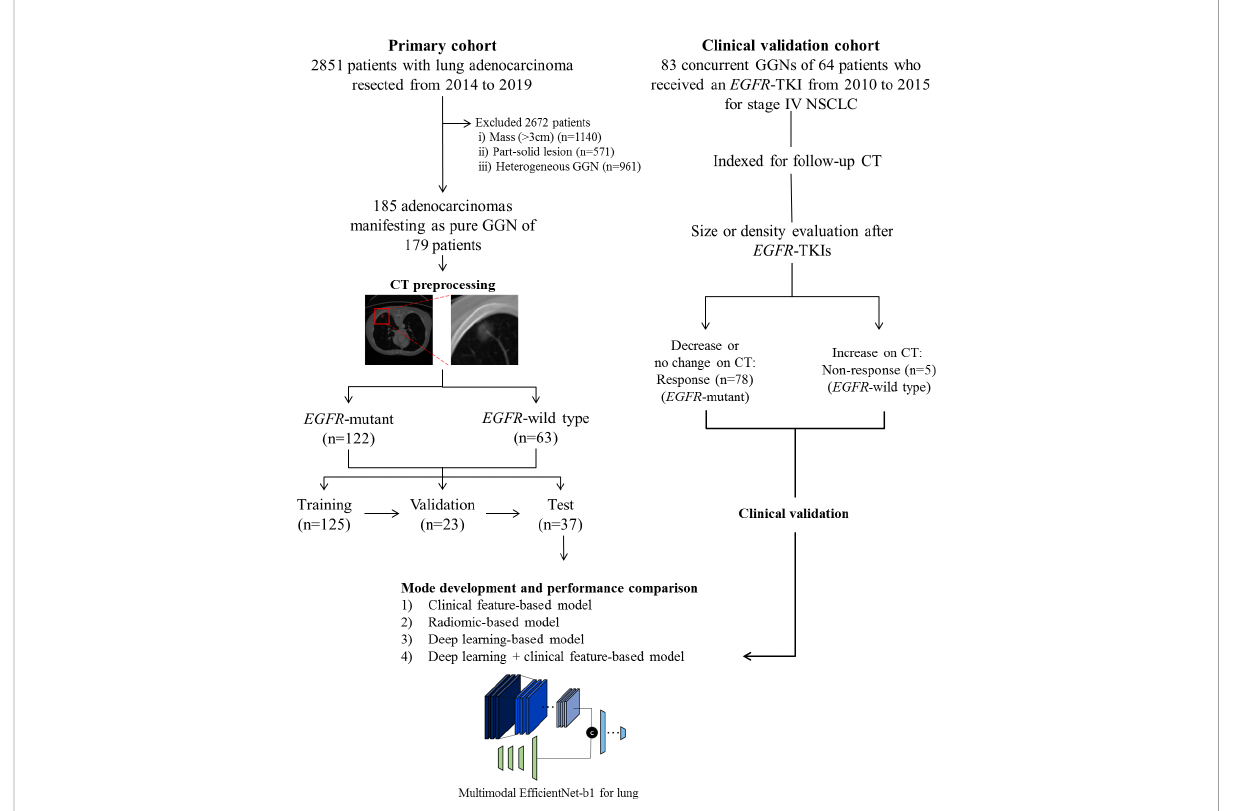
FIGURE 1 Flow diagram describing the development of the EGFR mutation prediction model in this